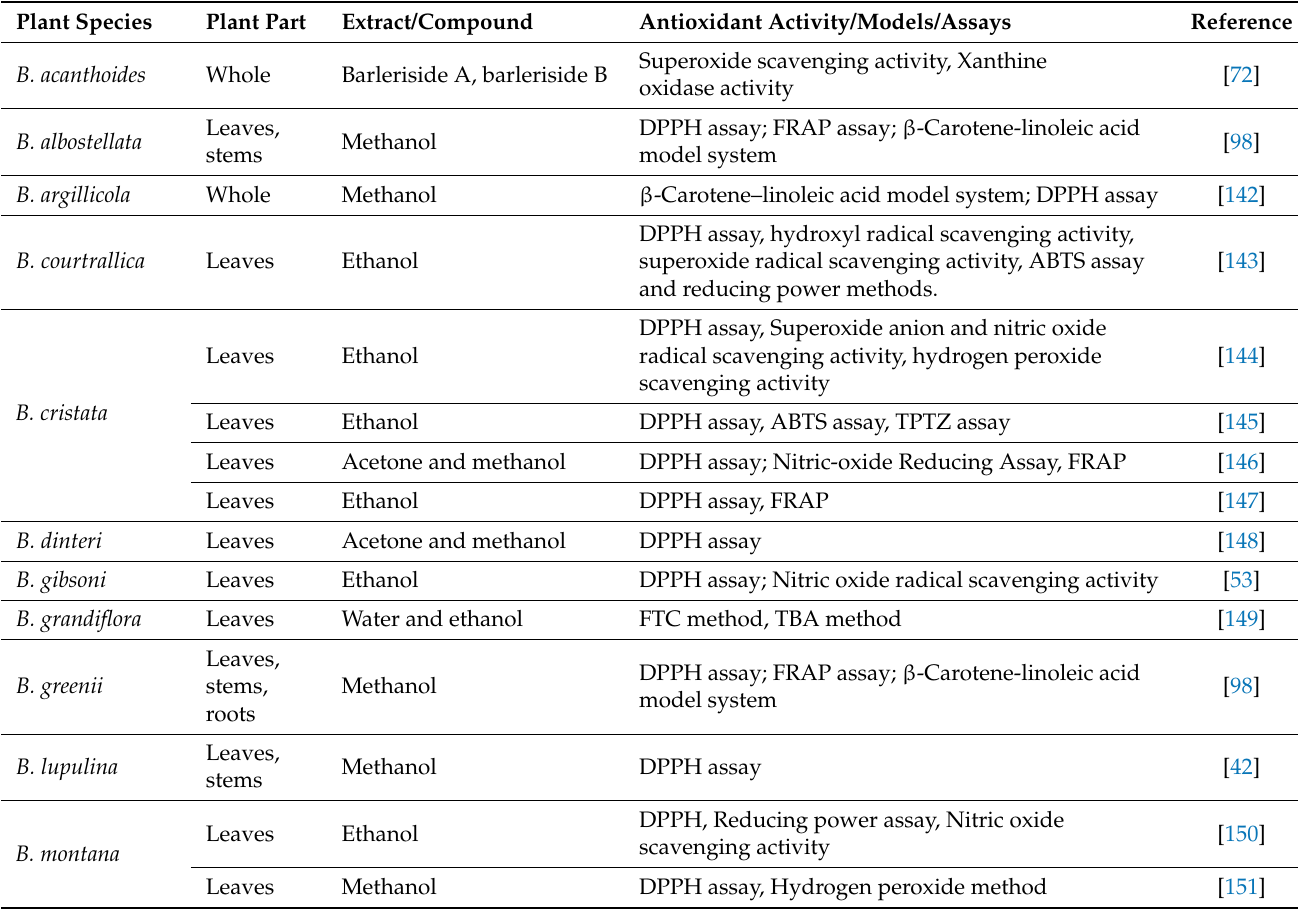
Table 2. Antioxidant properties of extracts and compounds isolated from Barleria